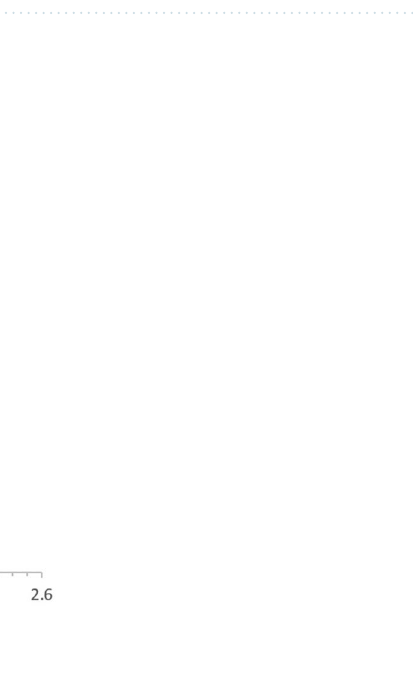
ductor material. The absorbance data is collected using a Carry 50 scan UV–Vis spectrophotometer within the wavelength of 300 nm to 1000 nm. Figure 6 shows the a 2 vs hv plots of CdMnTe layers grown at different cathodic potentials, where bandgap values vary between 1.72 eV and 2.22 eV. However, both the AD and CCT samples illustrate a sub-bandgap point of absorption for the material at ~ 930 nm, which matches the typical absorption wavelength of CdTe (Eg ≈ 1.45 eV). It is also noticeable that post-growth treatments make the mid-bandgap absorption edge sharper. Hence, it can be confirmed that, the XRD spectra found in “Structural study using X-ray diffraction (XRD) technique” section is contributed by both CdTe and CdMnTe crystals.